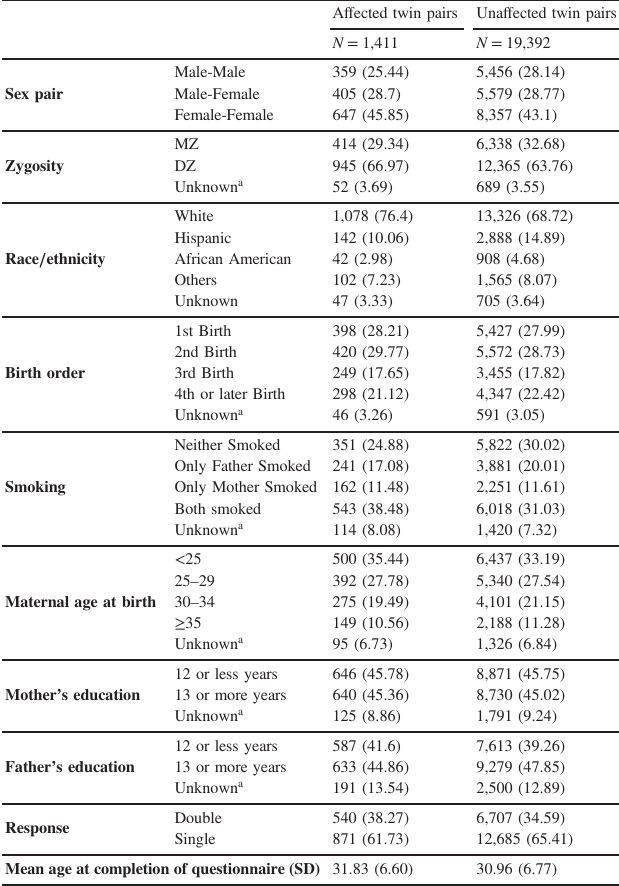
Table 1. Demographic characteristics by birth anomaly status among 20,803 twin pairs participating in the California Twin Program (Birth cohort 1957 –